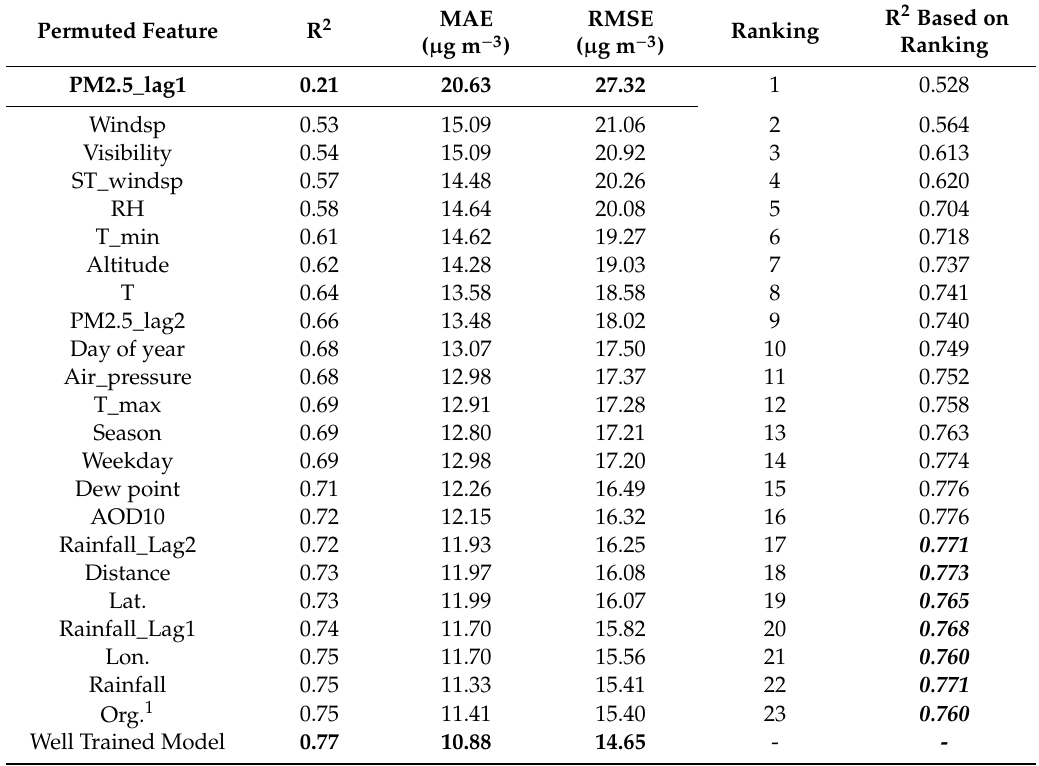
Table 6. Features permutation of a well-trained deep neural network (DNN) model and features permutation e ff ect on the prediction